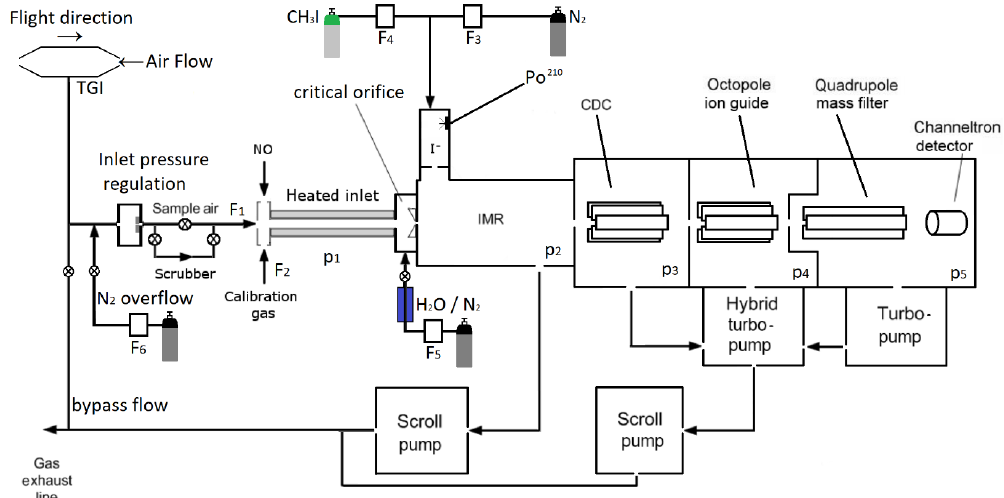
Figure 1. Schematic diagram illustrating the central components of the I-CIMS used in this work. IMR = ion–molecule reactor, CDC = collisional dissociation chamber, F 1 = 1250cm 3 ( STP ) min − 1 , F 2 = 50cm 3 ( STP ) min − 1 , F 3 = 750cm 3 ( STP ) min − 1 , F 4 = 4cm 3 ( STP ) min − 1 , F 5 = 50cm 3 ( STP ) min − 1 . p 1 = 100mbar, p 2 = 24mbar, p 3 = 0 . 6mbar, p 4 = 6 × 10 − 3 mbar, p 5 = 9 × 10 − 5 mbar. The heated inlet is made of PFA tubing. TGI = Trace-gas inlet. When overflowing the inlet line, the valve to the exhaust line is closed. When sampling air, the valve to the N 2 bottle is